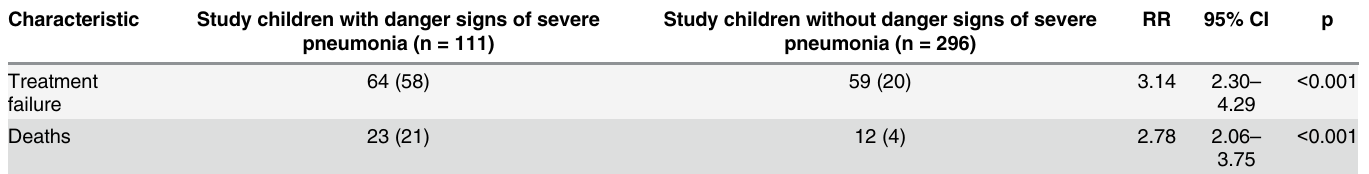
them only 2 (3%) children had bacteraemia. Other characteristics shown in Table 1 were also comparable between the groups.